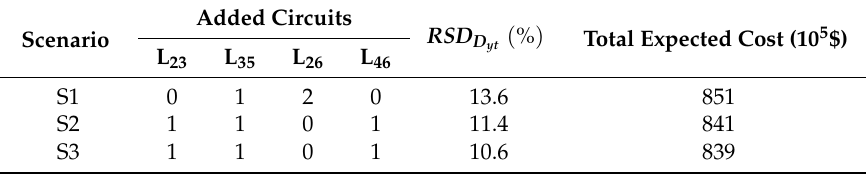
Table 6. Results for three Table 5. Different lead times of investment candidates.